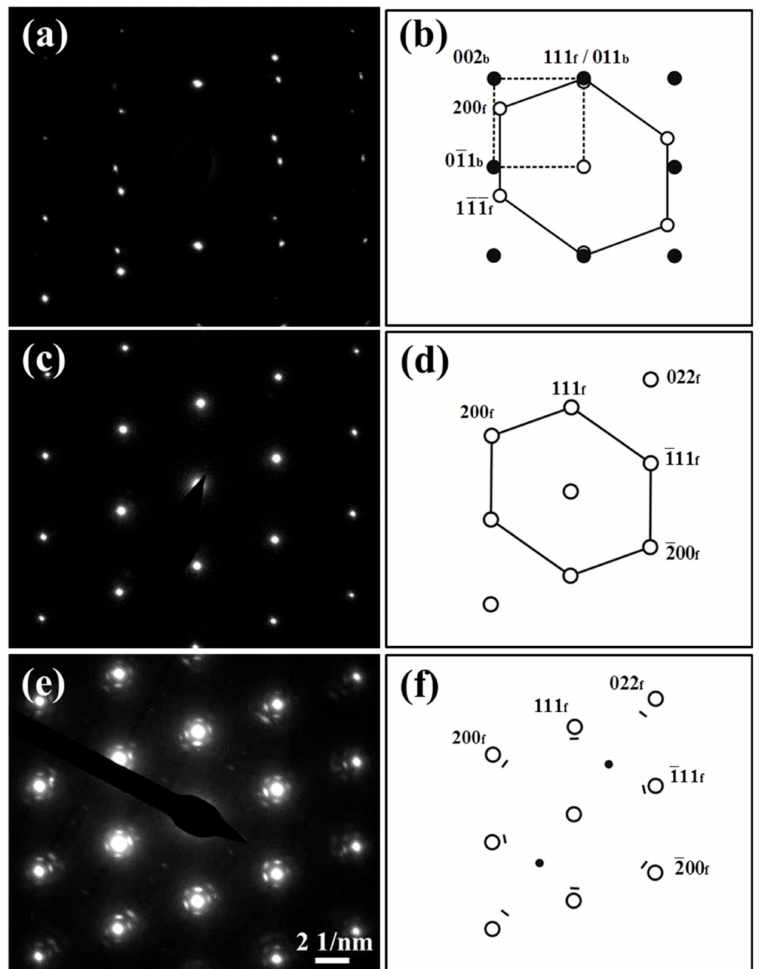
Figure 7. ( a , c , e ) [011] f SAD patterns taken from the areas of A, B and C indicated in Figure 6a,b, respectively and ( b , d , f ) schematic di ff raction patterns corresponding to ( a ), ( c ) and ( e ), respectively. ( b ), ( d ) and ( f ) show positions of the reflections ( (cid:8) ) from the bcc α -Fe particle, reflections ( (cid:13) ) from the fcc Cu matrix, fundamental ( − ) and superlattice ( • ) reflections from the initial decomposition product. All other reflections in ( e ) arise due to double di ff